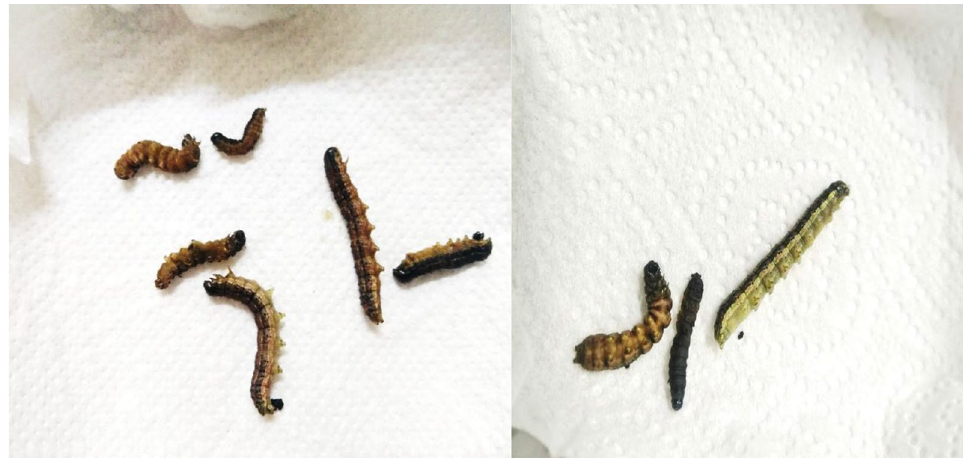
Fig. 2 Mortality of different larval instars of Spodoptera frugiperda after the application of EPNs, Steinernema carpocapsae